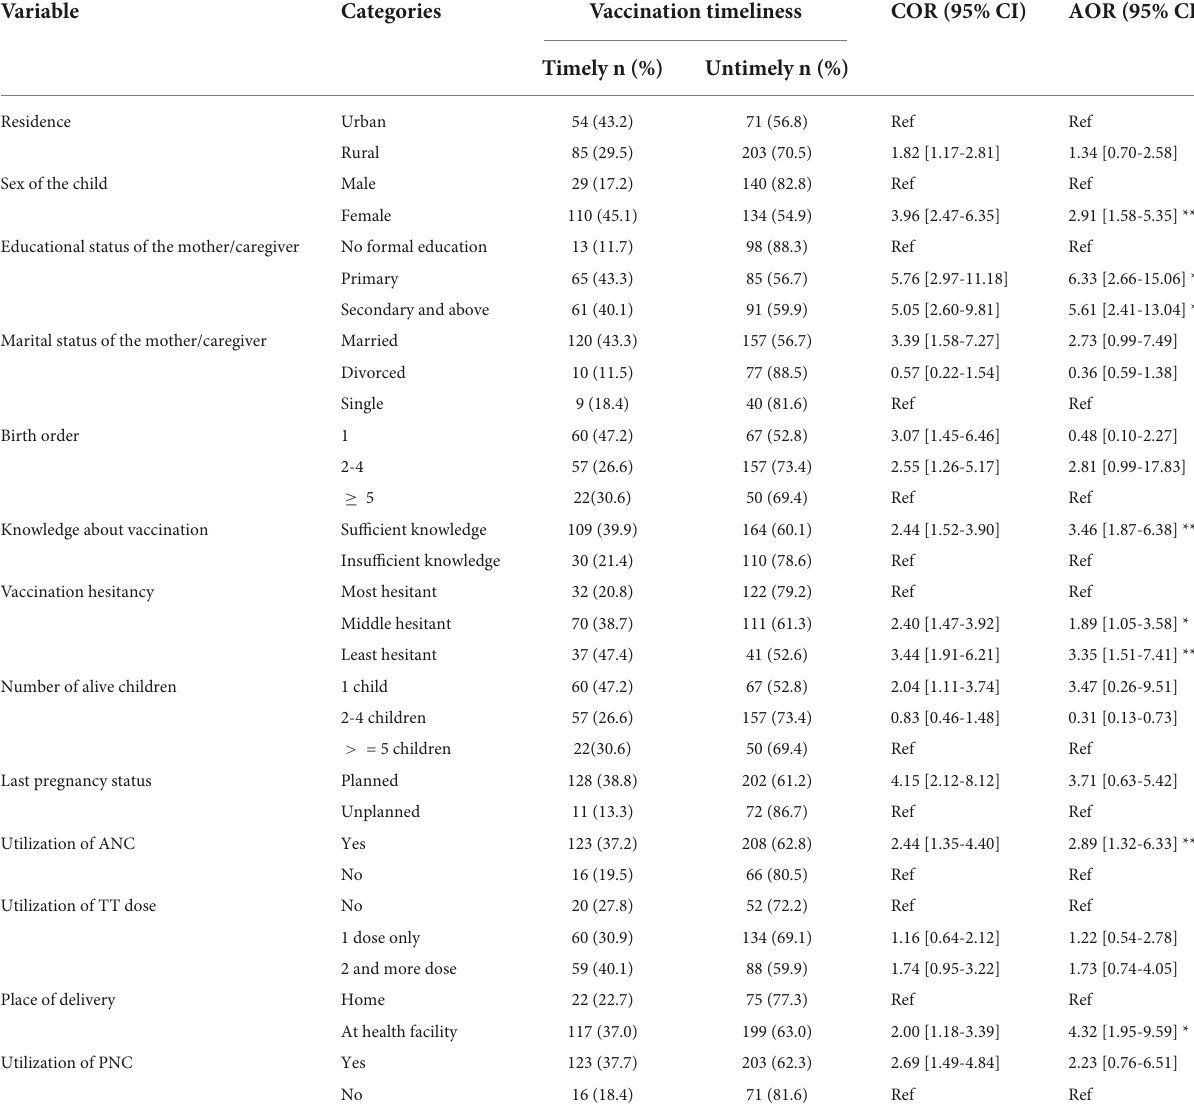
TABLE 5 Factors associated with vaccination timeliness among children aged 12–23 months in Debre Libanos district, North Shewa Zone, Oromia Region State, Ethiopia